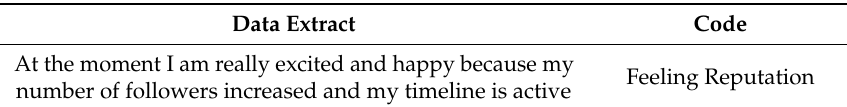
Table A2. Example of the thematic analysis.